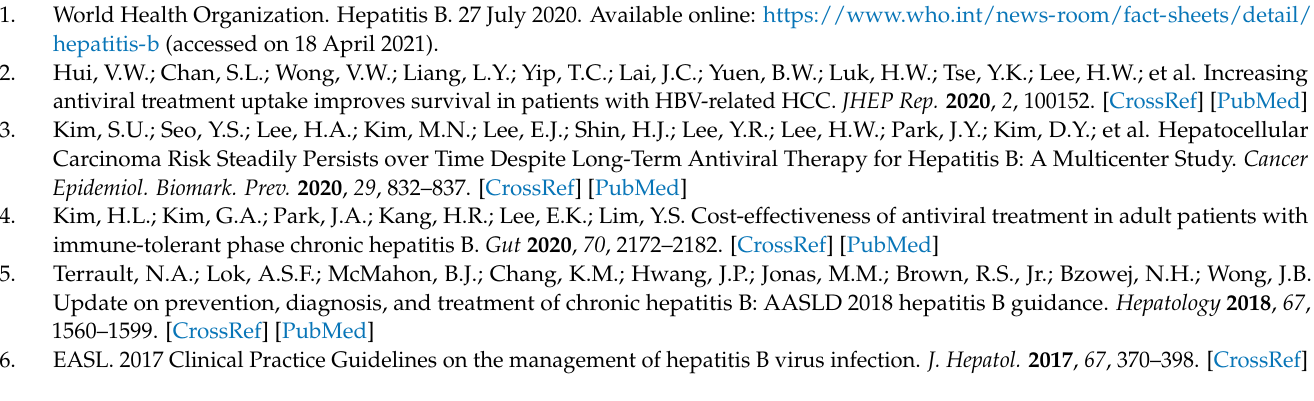
Figure S2: Pooled analysis of representative HRs presented in individual papers/multivariable- adjusted HR/propensity score-matched HR in the cirrhotic subcohort, Figure S3: Pooled HR from a subgroup analysis according to the starting point, Figure S4: Pooled HR from a subgroup analysis after excluding alcoholic liver disease, Table S1: Search strategies; Table S2: Newcastle-Ottawa scale for non-randomized studies (abstracts were excluded from assessment), Table S3: Adjusted variables for Cox regression analyses for risk of HCC development in the included articles, Table S4: Adopted variables for propensity score matching analysis to reduce selection bias and the effect of potential confounders in the included articles, Table S5: Statistical methods used in the included articles, Table S6: Characteristics after propensity score matching analysis in the included studies, Table S7: Reimbursement policies for antiviral